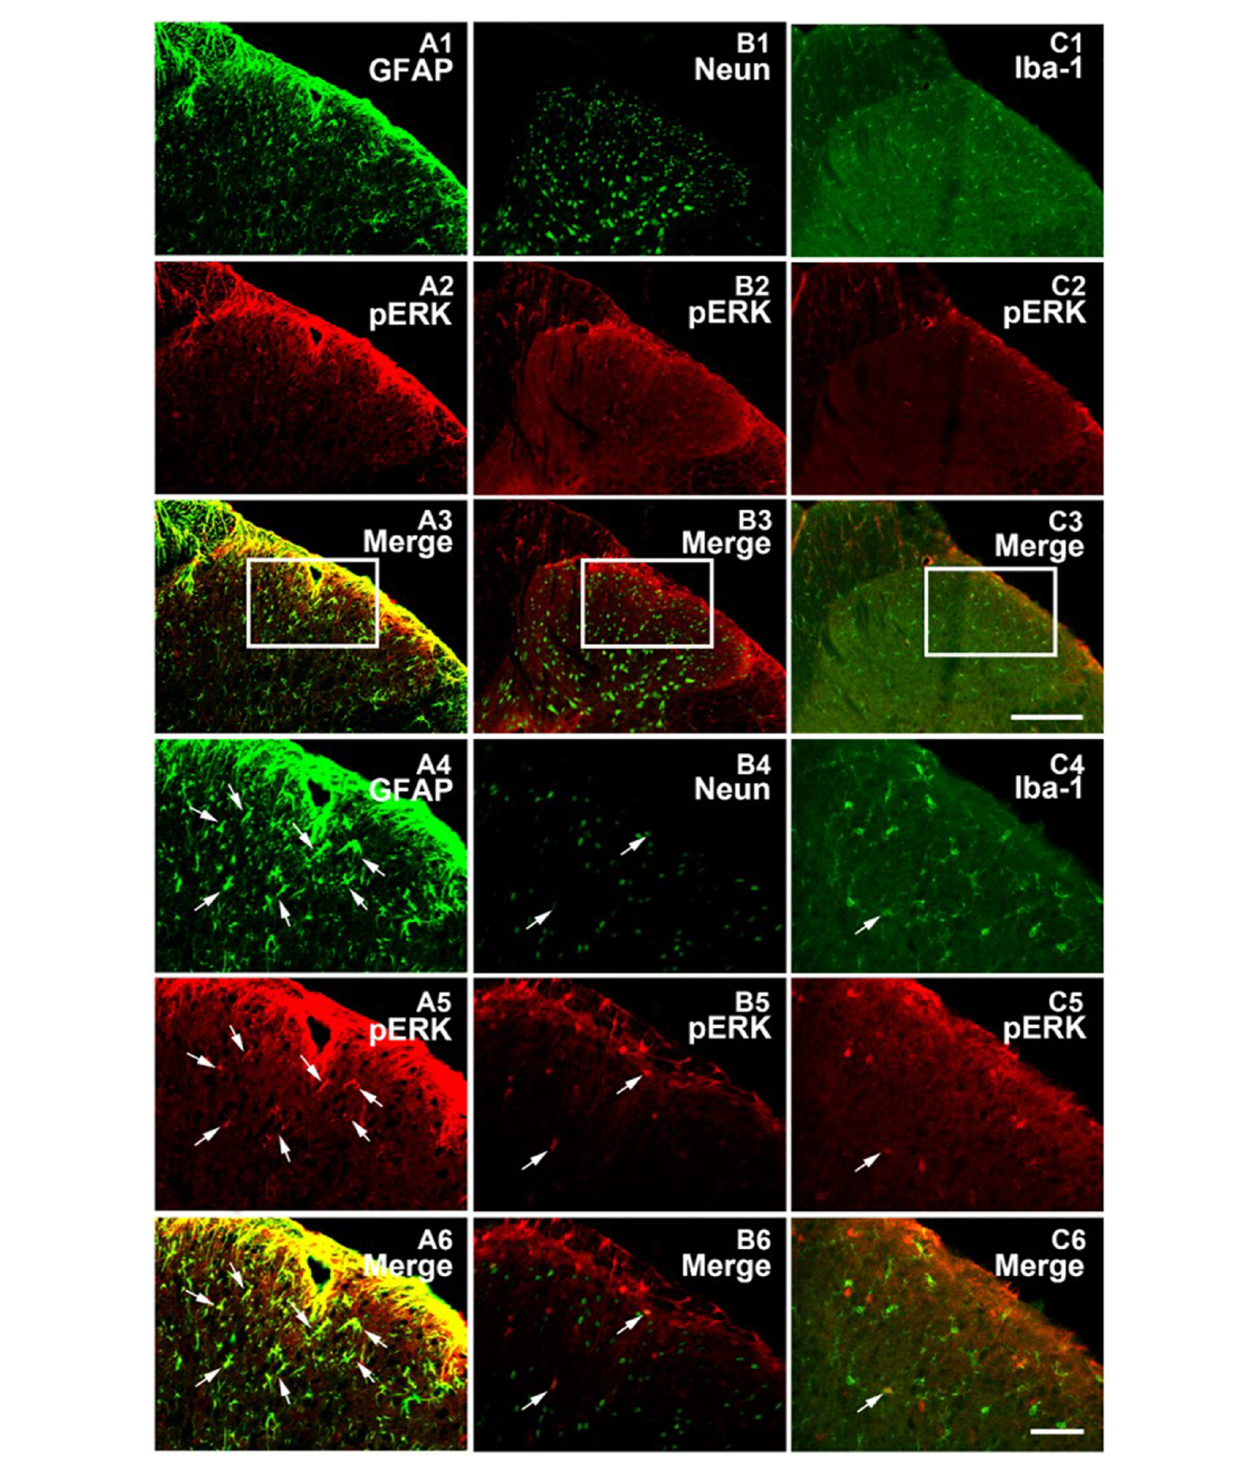
FIGURE 4 | pERK was primarily expressed within spinal astrocytes in the SNL model on POD 15. Microphotographs indicating double-immunofluorescence histochemistry for pERK (red) and glial fibrillary acidic protein (GFAP; A1–A6 ) or NeuN (B1–B6) or Iba-1 ( C1–C6 ; green) immunoreactivities within ipsilateral spinal dorsal horn in the SNL model on POD15. The framed areas in images (A1–A3,B1–B3,C1–C3) were magnified in images (A4–A6, B4–B6, C4–C6) , respectively. White arrows showed double-labeled neurons in each set pictures. Bars = 100 µ m in images (A1–A3,B1–B3,C1–C3) and 40 µ m in images (A4–A6,B4–B6,C4–C6) .